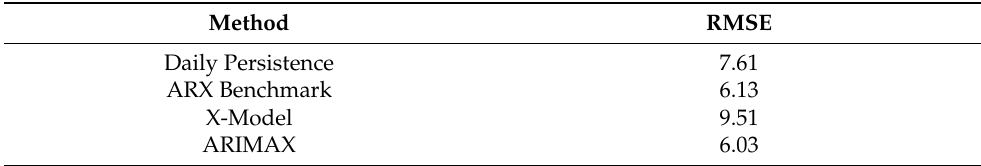
Table 1. Average RMSE score of each method over the entire test set. Method RMSE Daily Persistence